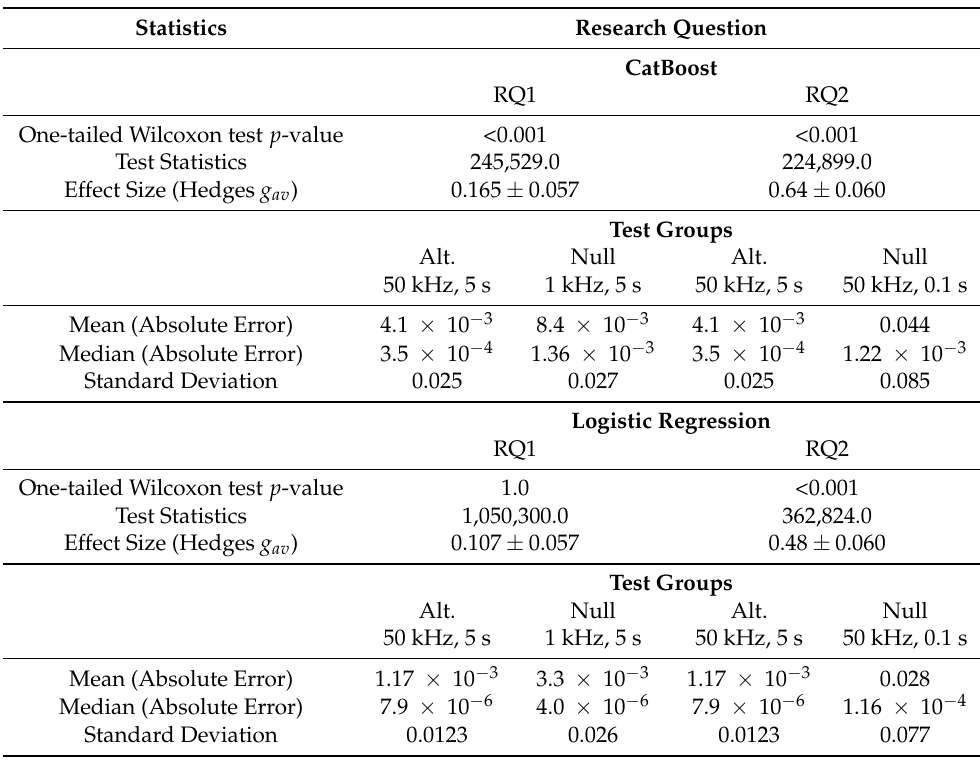
Table 9. The table communicates the statistical test outcomes as well as supporting sample statistics. “Alt.” and “Null” correspond to the alternative and null hypothesis, respectively. Below those, we indicate the particular experiment representing the hypotheses. The tests and the sample statistics are computed on the absolute per-entry-per-class classification errors. Statistics Research Question CatBoost RQ1